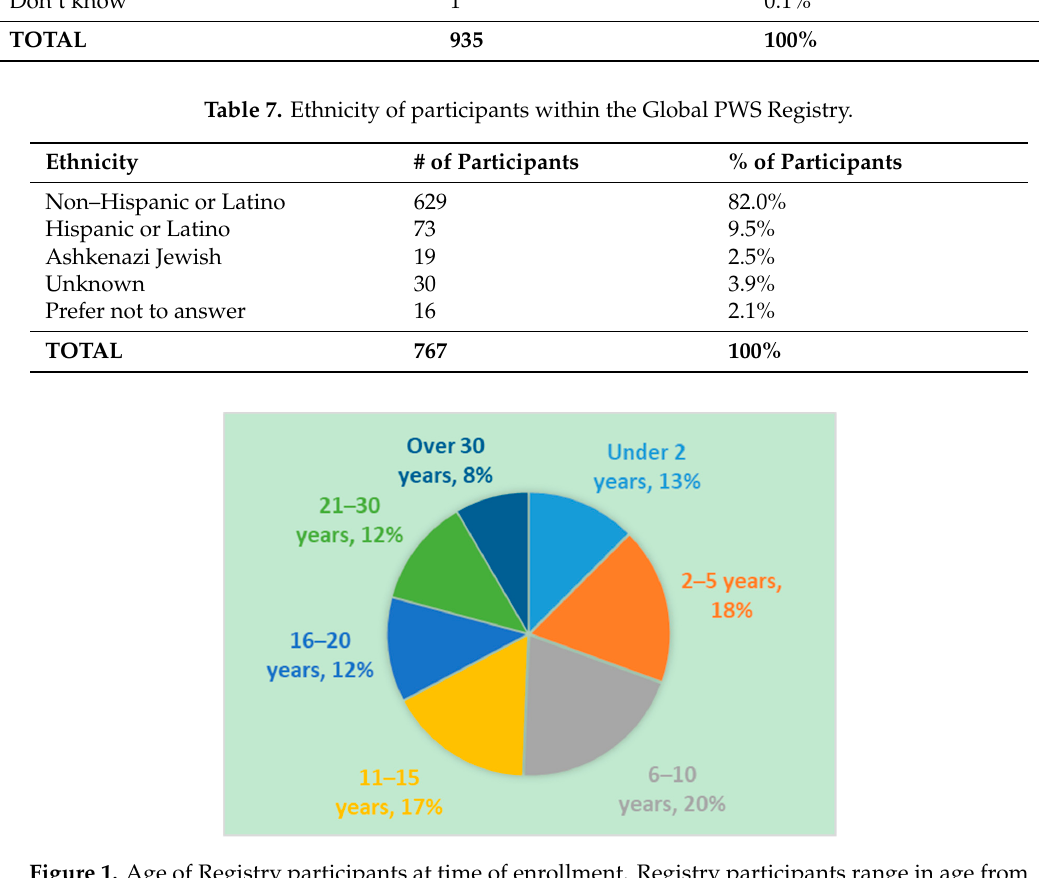
Figure 2. Gender of Registry participants.